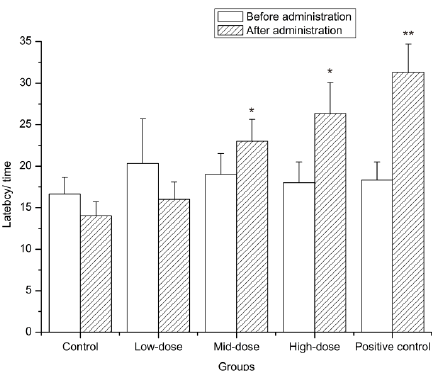
Figure 4. Antinociceptive effects of wICM in hot-plate test. Data are expressed as the means ± SD. * shows p < 0.05 compared with the control group; ** shows p < 0.01 compared with the control group.